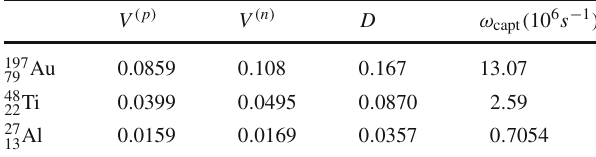
/ 2 Table 7 The overlap integrals in the units of m 5 μ and the total capture rates for different nuclei [86]. The total capture rates are taken from Table 8 in [86]. The overlap integrals of 197 Au as well as 27 Al are taken 79 13 from Table 2 and 48 Ti are taken from Table 4 of Ref. 22